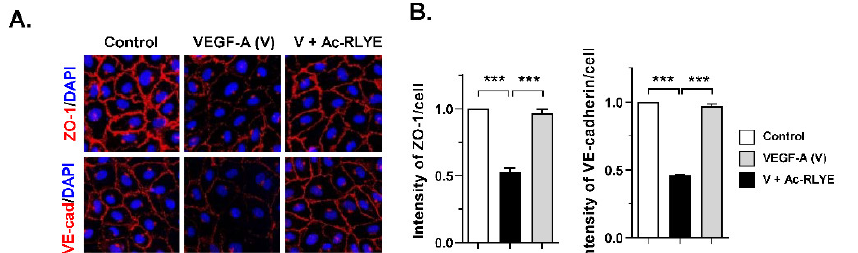
Figure 1. Ac-RLYE inhibits VEGF-A-induced junctional integrity loss in HUVECs. Cells were pre- treated for 30 min with Ac-RLYE (0.15 nM) followed by stimulation with 10 ng/mL VEGF-A (V) for 1 h. ( A ) Confocal images of ZO-1 and VE-cadherin. ( B ) Quantification of ZO-1 and VE-cadherin at contact sites between endothelial cells ( n = 3). Data are represented as mean ± SD values. *** p < 0.001.